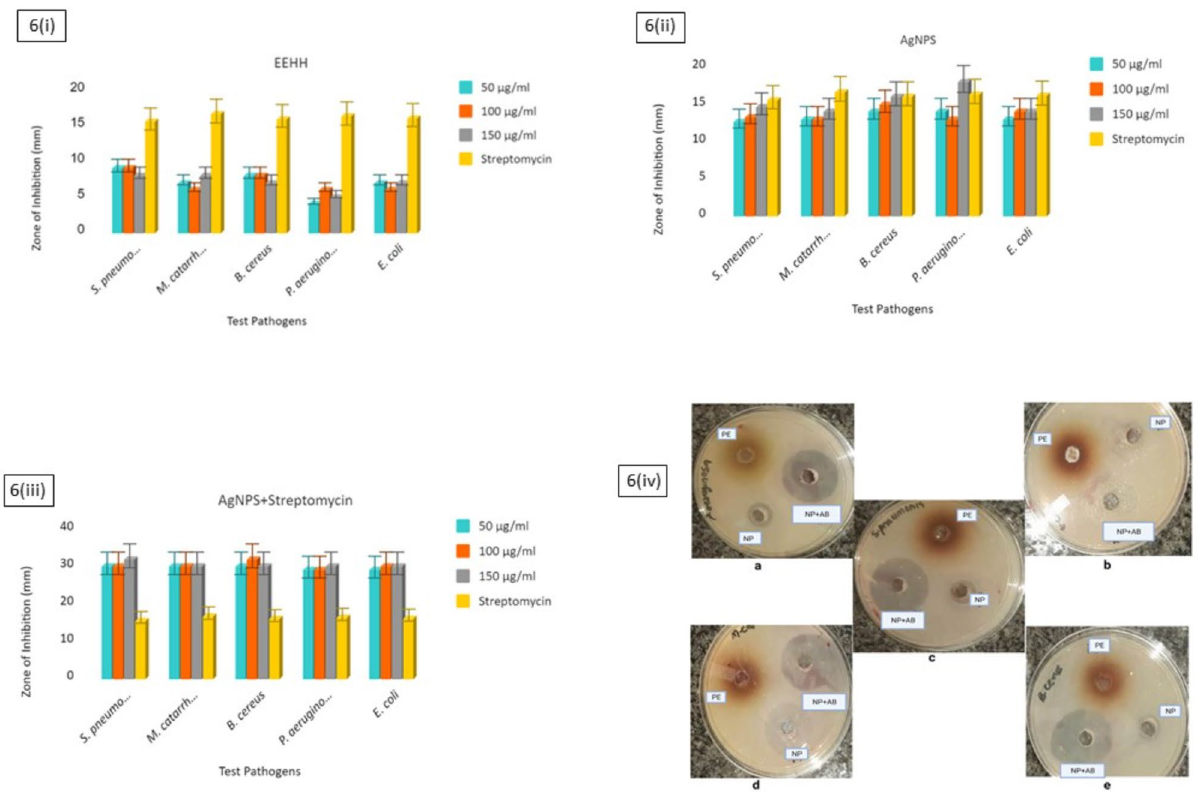
Figure 6. The antibacterial activity of ( i ) EEHH, ( ii ) AgNPs, ( iii ) AgNPs and Streptomycin (10 μg/mL for all experiments), ( iv ) zone of inhibition on agar plate. Bacteria MIC (µg/mL) MBC (µg/mL) RF